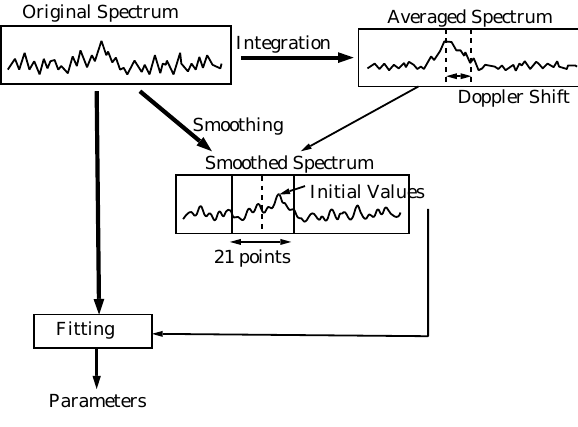
Fig. 3. Flowchart for deciding the initial value of